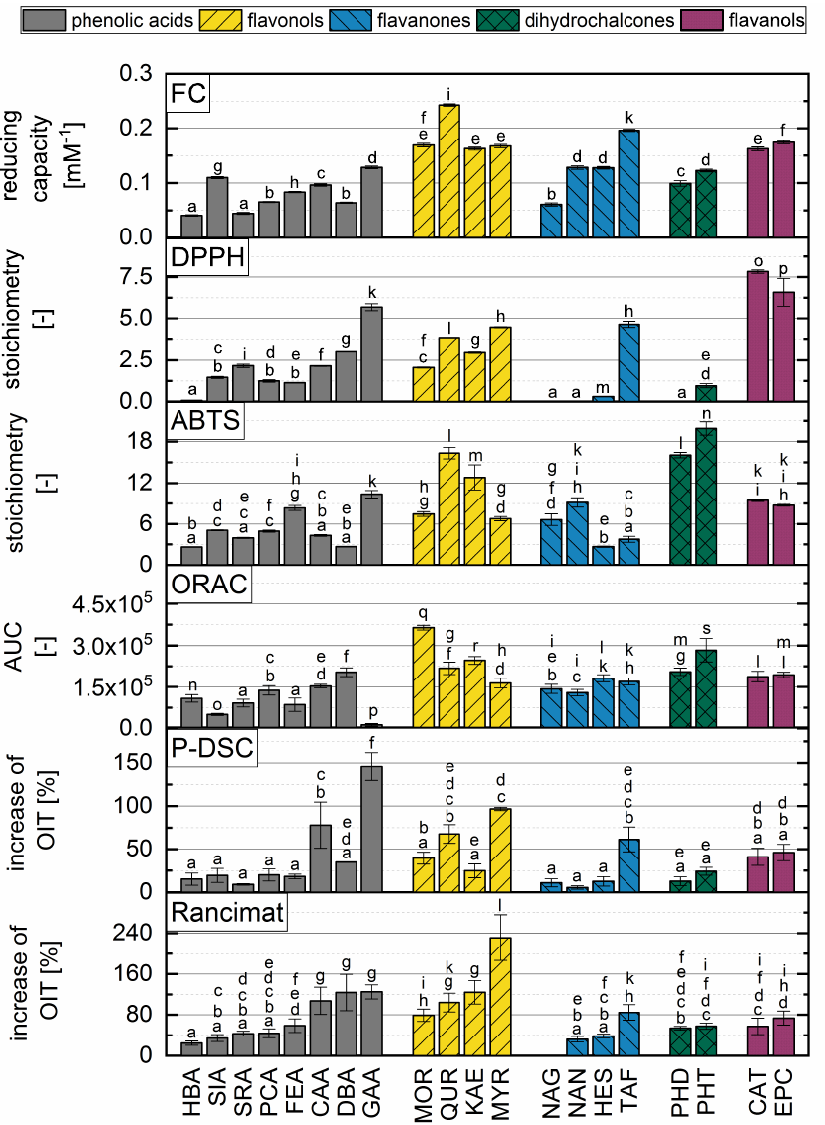
Figure 1. OIT increase in relation to rapeseed oil of all standard reference compounds determined by Rancimat method and P-DSC in comparison to ORAC, ABTS, DPPH and FC assay results (adapted with permission from Platzer et al. [76–78]). The results are shown as mean values with standard deviations for the concentration of 1 mM for all samples and all measured methods. Equal letters indicate that there is no significant difference between the results with an significance level at p >